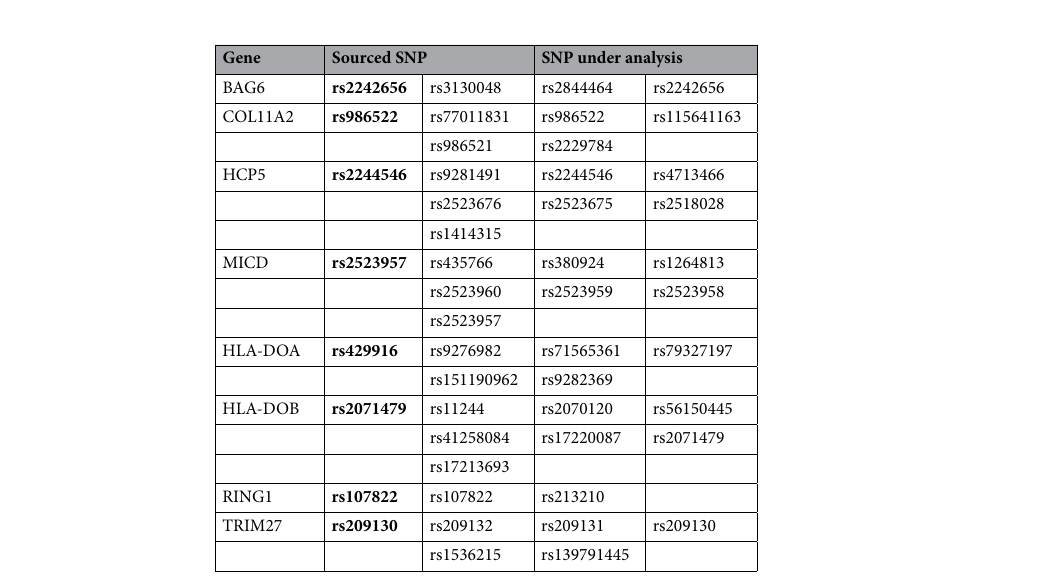
Table 2. The SNPs flanking the 8 sourced SNPs under analysis in this